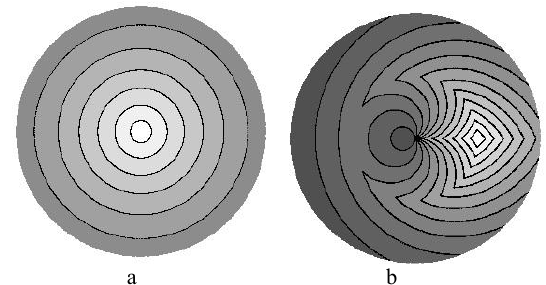
Figure 11. Normalized correlation function of circular image: a) relative to the center, b) relative to the middle of a radius